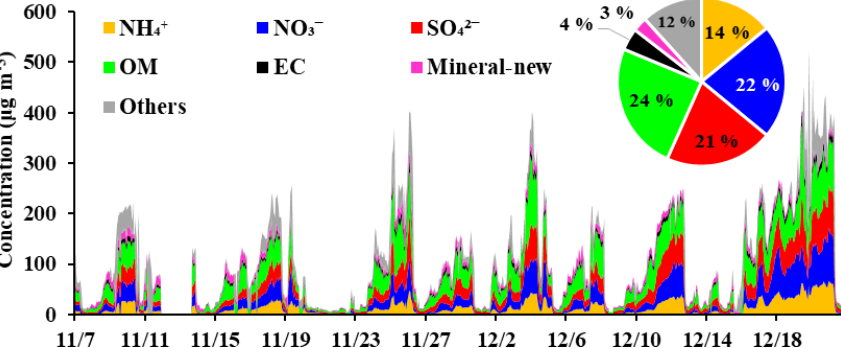
, blue for NO − , yellow for NH + , green for OM, black for 4 3 4